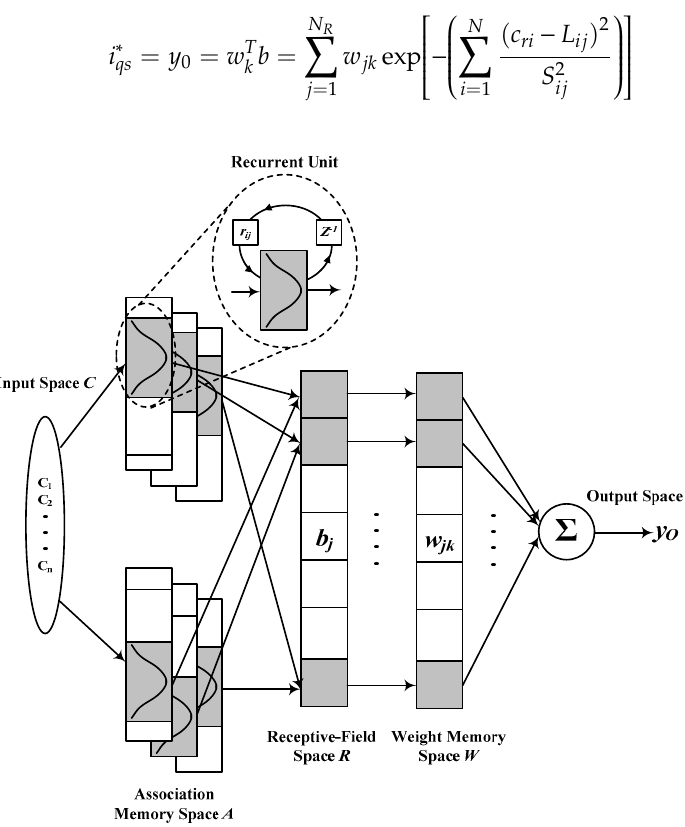
Figure 2. Proposed RCMAC architecture.